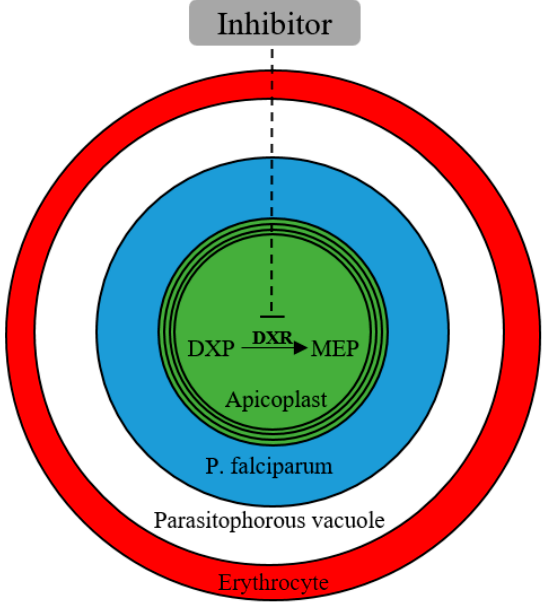
Figure 3. Passage of DXR inhibitors across seven membranes in Plasmodium -infected erythrocytes. Adapted with permission from J. Med. Chem . 2015, 58, 4, 2025–2035 [37]. Copyright 2022 American Chemical Society.